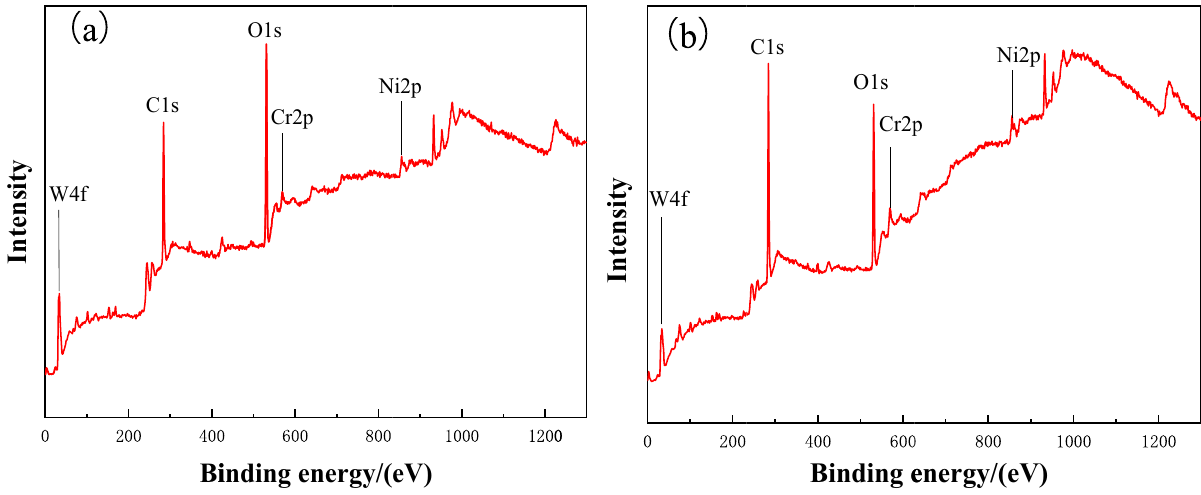
Figure 11: XPS full spectrum of sample surface after immersing in: ( a ) 3.5 wt% NaCl solution; ( b ) 0.5 mol · L − 1 HCl